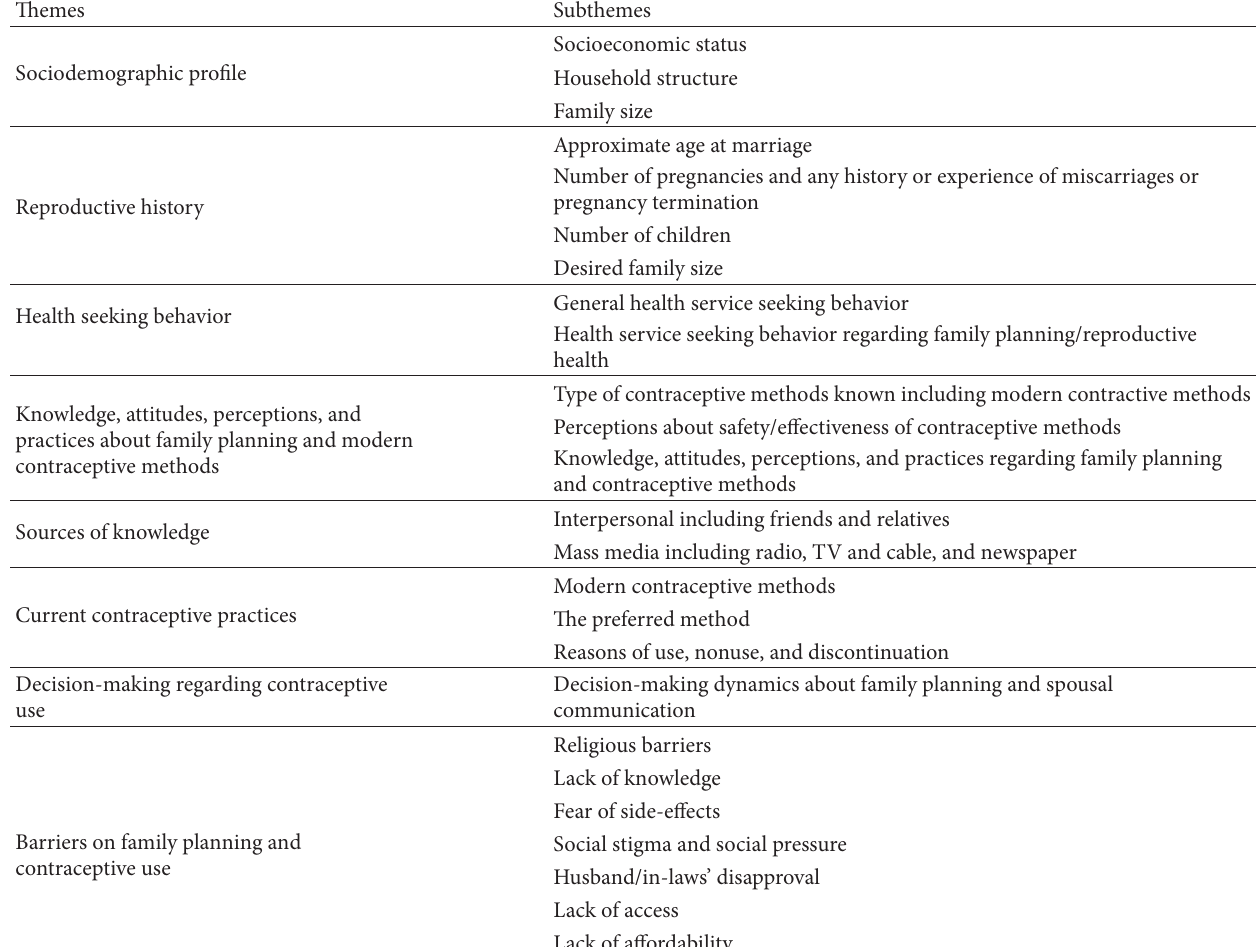
Table 2: Identified themes and